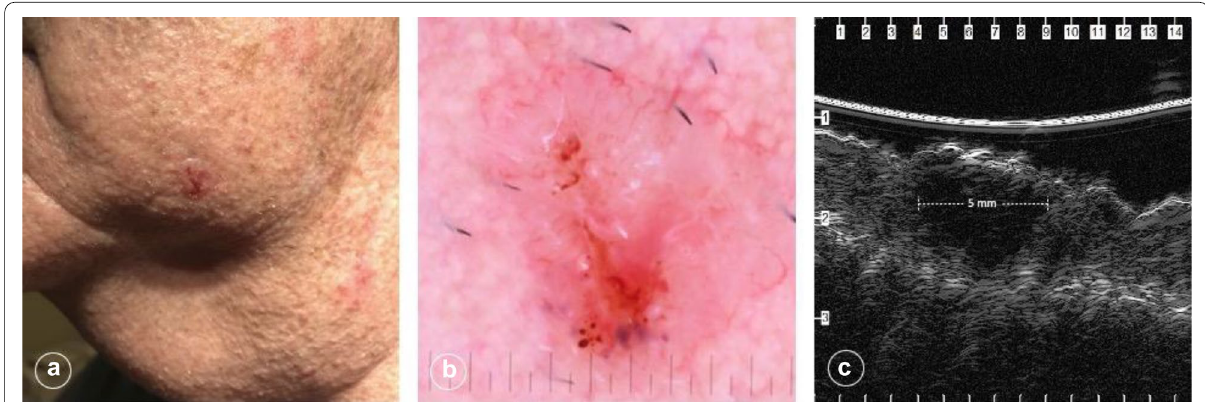
Fig. 4 Nodular basal cell carcinoma measuring 5 mm by 7 mm on the left lower cheek of a 66-year-old man. Note the pearly borders and central ulceration in the gross photograph ( a ), the polymorphous vessels and ulceration in the dermatoscopic photo ( b ), and the 5 mm hypoechoic lesion in the superficial dermis across the short axis of this biopsy-supported nodular basal cell carcinoma using a 50-MHz UHFUS probe (Longport, Inc.